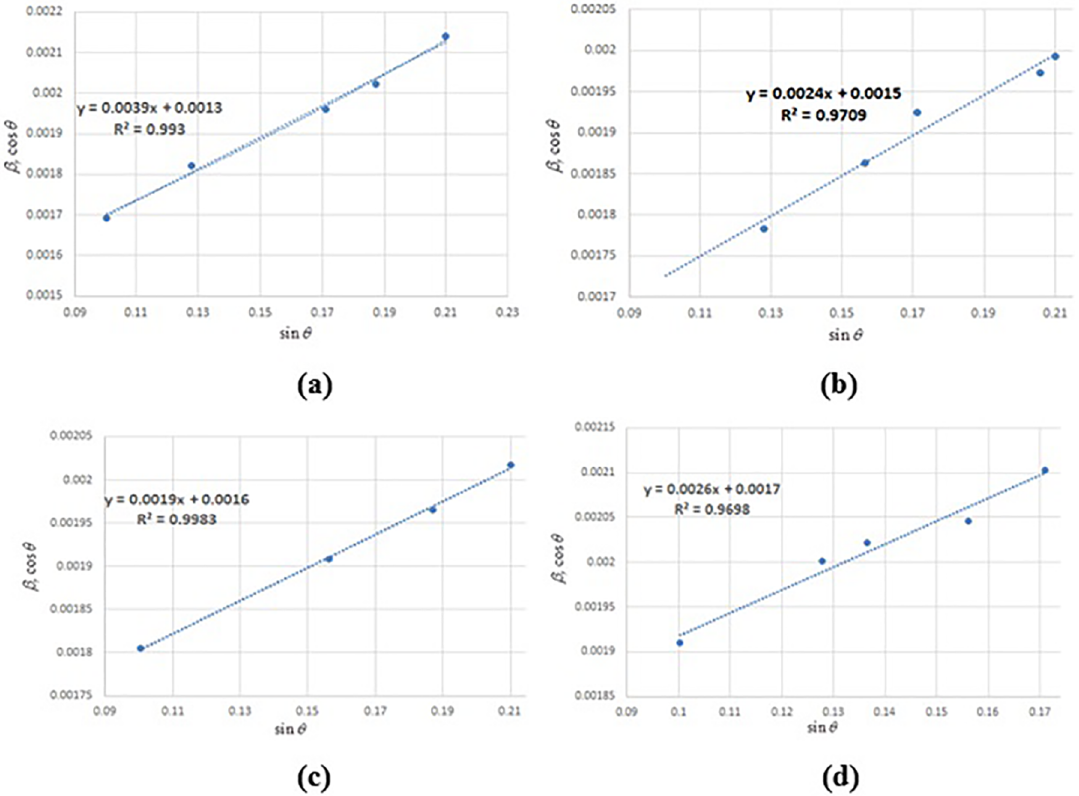
cos θ against sin θ of CaCO annealed at (a) 300°C, (b) 350°C, (c) 400°C and (d) 450°C. Figure 4. Plot of β r 3 Table 2. Crystallite size and lattice strain versus annealing temperature of CaCO Annealing temp. (ºC)